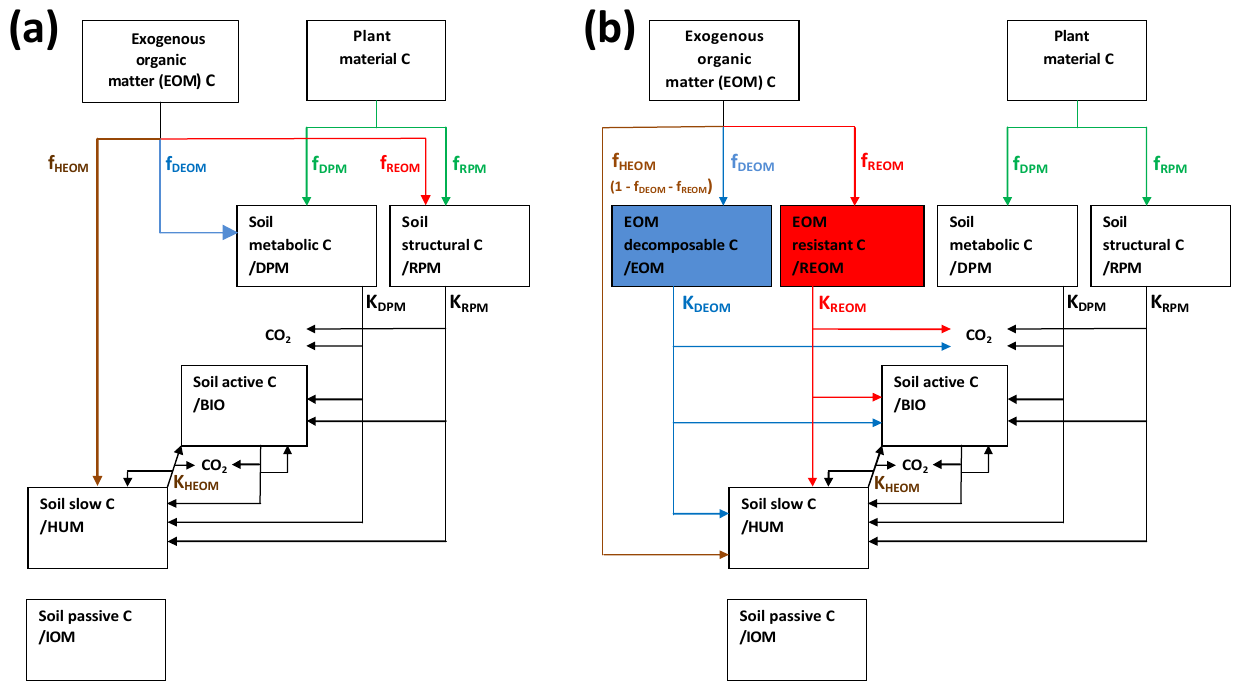
Figure 2. Structure of the standard (a) and modified (b) RothC model. DPM: decomposable plant material; RPM: resistant plant mate- rial; EOM: exogenous organic matter; DEOM: decomposable EOM; REOM: resistant EOM; HEOM: humified EOM; BIO: soil microbial biomass; HUM: humified soil organic matter; IOM: inert organic matter; f : partitioning factor; K : decomposition constant rate (yr − 1 )